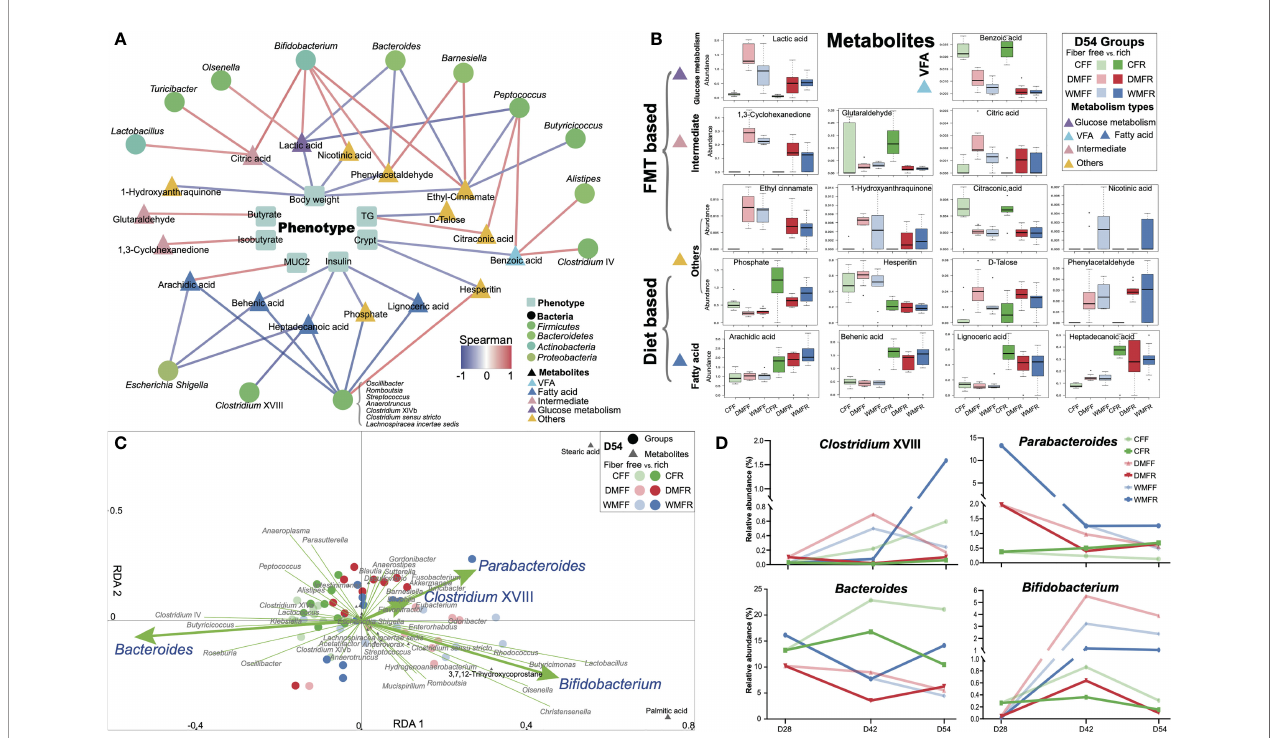
FIGURE 6 | Differential bacteria and metabolites in the gut contribute to the phenotypes of mice treated with fecal microbiota transplantation (FMT) together with dietary fi ber intervention at day 54. (A) Correlation between differential metabolites and phenotypes ( p < 0.05), differential bacteria, and metabolites in the gut of mice ( p < 0.01). (B) Box plot of the differential metabolites correlated with gut microbiota and phenotypes of mice. (C) Redundancy analysis (RDA) revealed that gut microbiota contributes to variation of the metabolites in the gut of mice. (D) Alteration in the relative abundance of the differential gut microbiota in RDA within the dietary fi ber intervention after FMT of the